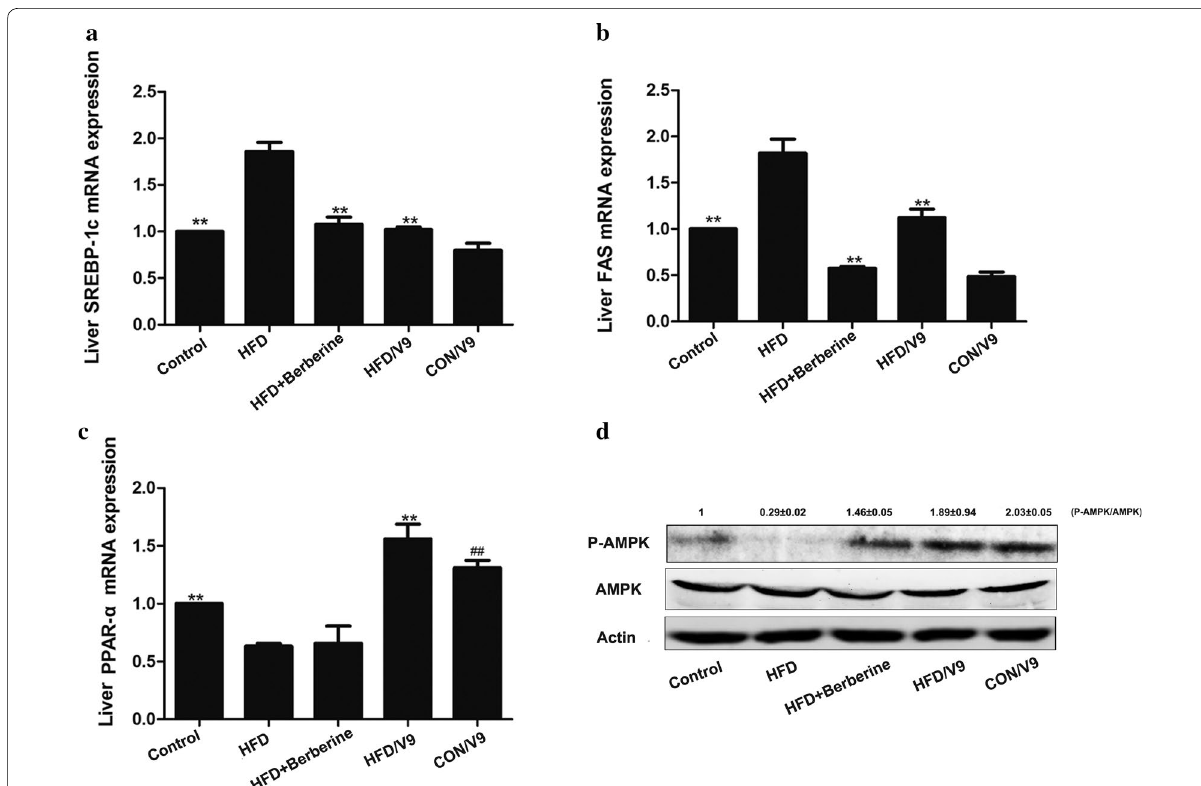
Fig. 3 Probiotic V9 regulate the expression of the genes in lipid metabolism. Relative SREAP-1c ( a ), FAS ( b ), and PPAR-α mRNA expression ( c ) are reported (n 8 each group). # P < 0.05 vs control group, and **P < 0.01 vs HFD group. d Western blotting analysis of hepatic phospho-AMPK = (p-AMPK) and total AMPK. The representative picture is one from three independent experiments. The densitometric analysis of bands from all samples was shown as the fold change relative to the control